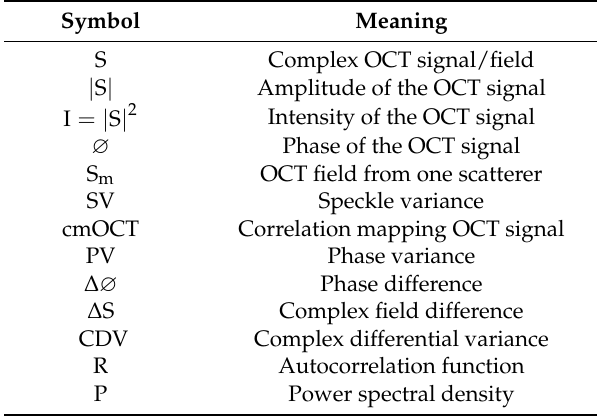
Table 1. Symbols or variables used and their